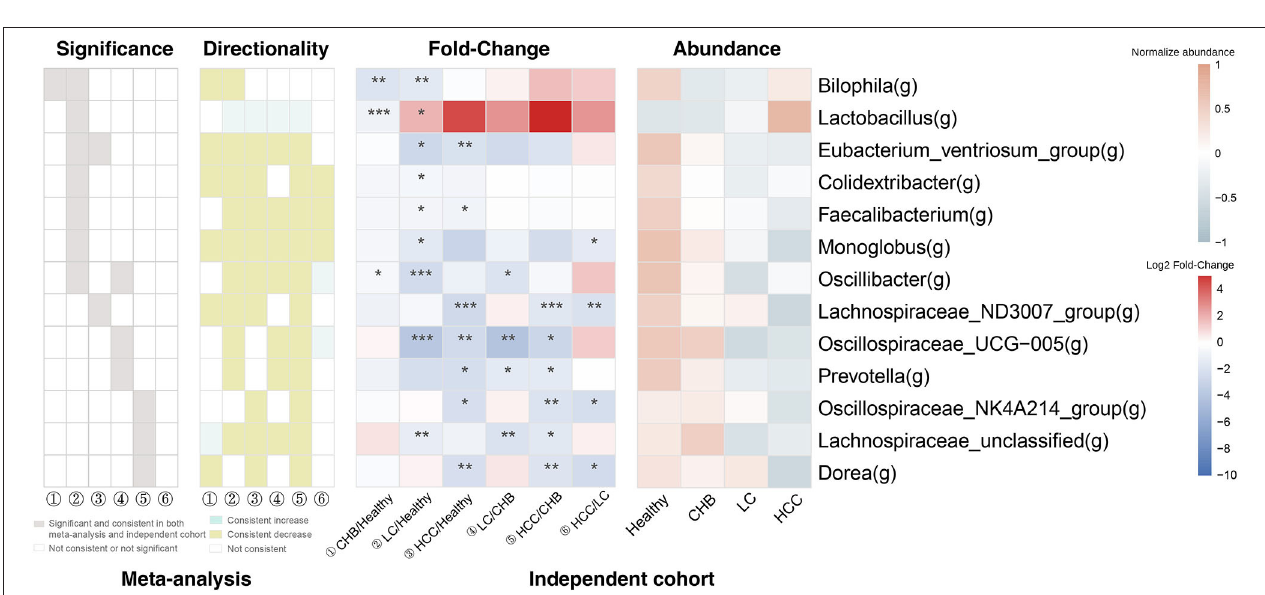
FIGURE 3 | Overview of the gut microbiome in the validation cohort. (A) Alpha diversity for each disease status concluding Chao1, ACE, Shannon and Simpson. The differences were calculated by Wilcoxon test on genus level. * p < 0.05; *** p < 0.001. (B) Principal Coordinates Analysis (PCoA) of microbiome beta-diversity based on Bray-Curtis dissimilarity index.